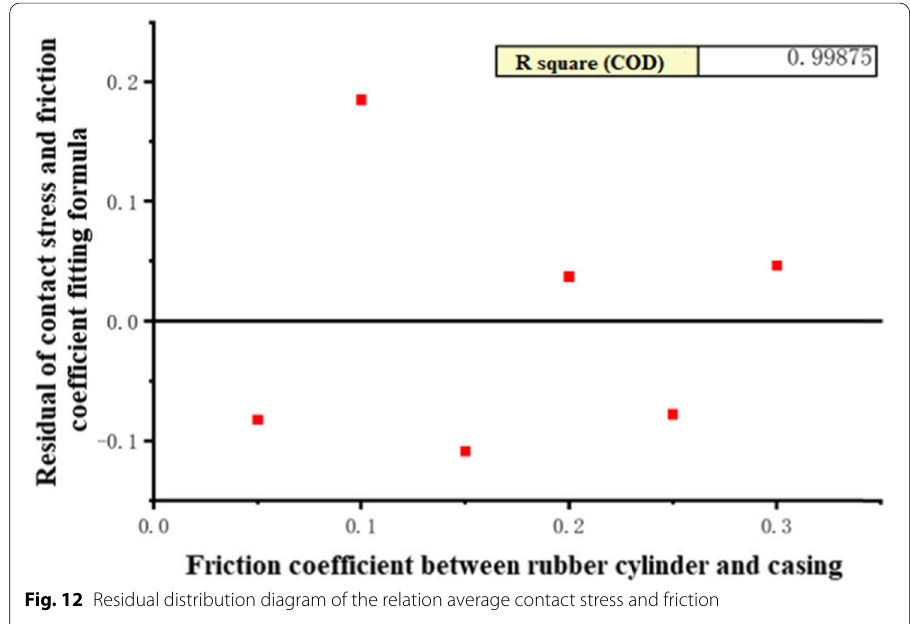
Fig. 12 Residual distribution diagram of the relation average contact stress and friction coefficient